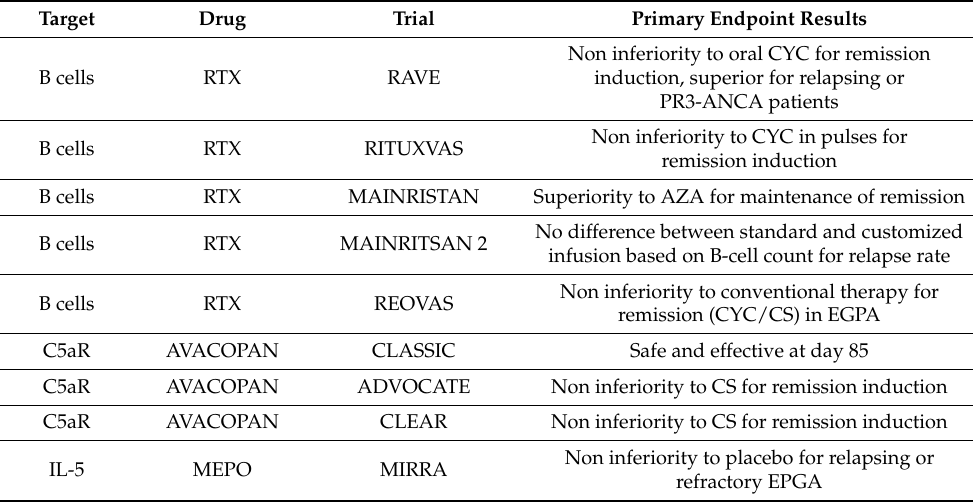
Table 1. Trials on currently approved new drugs for